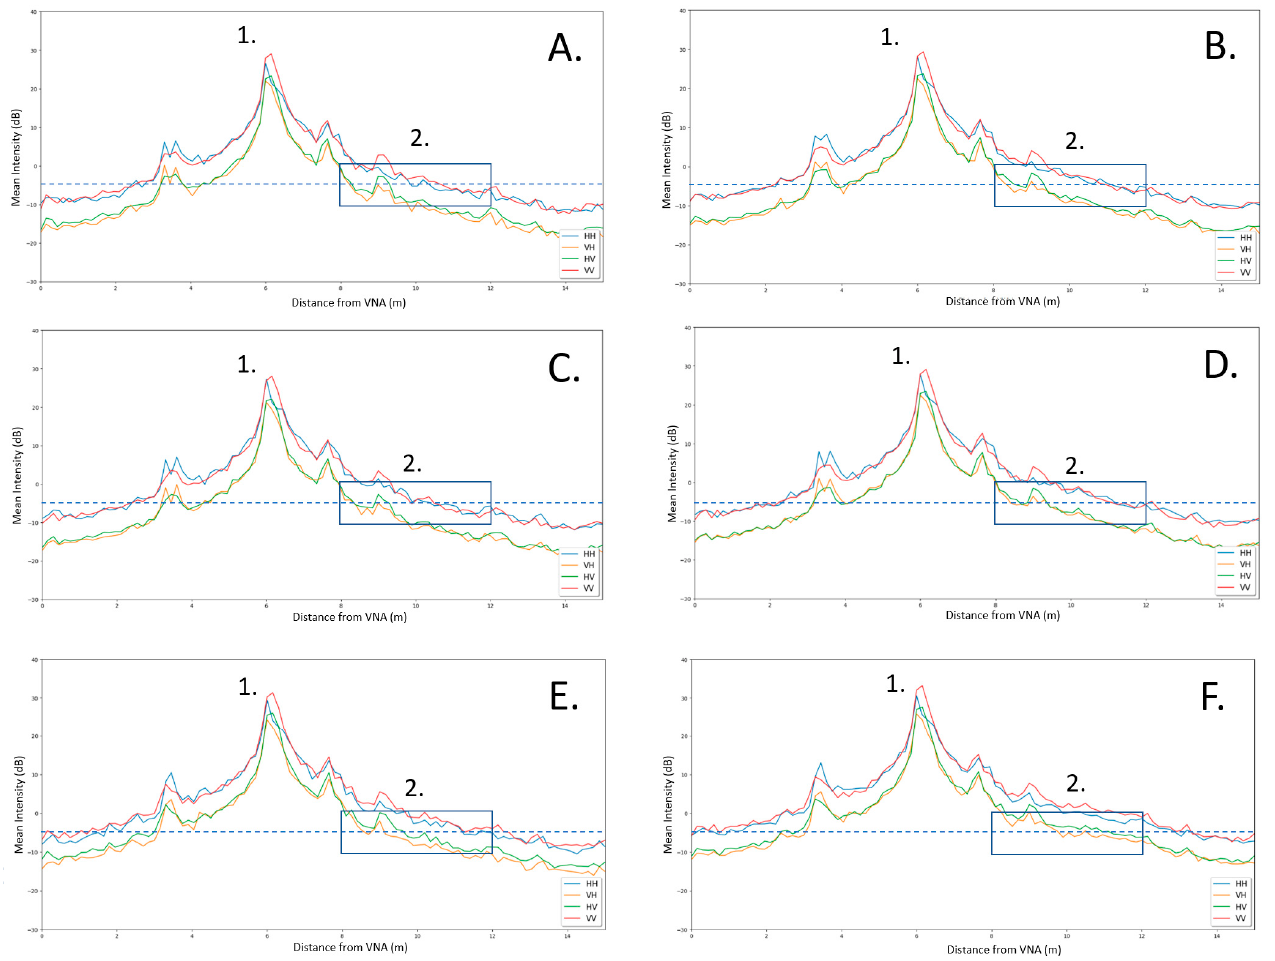
Figure 6. C-band intensity plots of irregular wave reference acquisitions (Left) and test acquisitions (Right). 1. Peak of intensity from the lip of the bridge by radar set-up. 2. ROI within wave tank (also highlighted by a blue box). Dashed: arbitrary reference line to aid visualisation (Top). Nine centimetre irregular wave conditions for reference ( A ) and test ( B ). Test = 40 g/m 2 of plastic bo tt les inside tank (2 bo tt les/m 2 ) (Middle). Nine centimetre irregular wave conditions for reference ( C ) and test ( D ) conditions. Test = 20 g/m 2 of plastic foam cylinders (20 cm long) inside tank (Bo tt om). Seventeen centimetre irregular wave conditions for reference ( E ) and test ( F ) conditions. Test = 10 g/m 2 of plastic lids inside tank (1.5 lids/m 2 ).